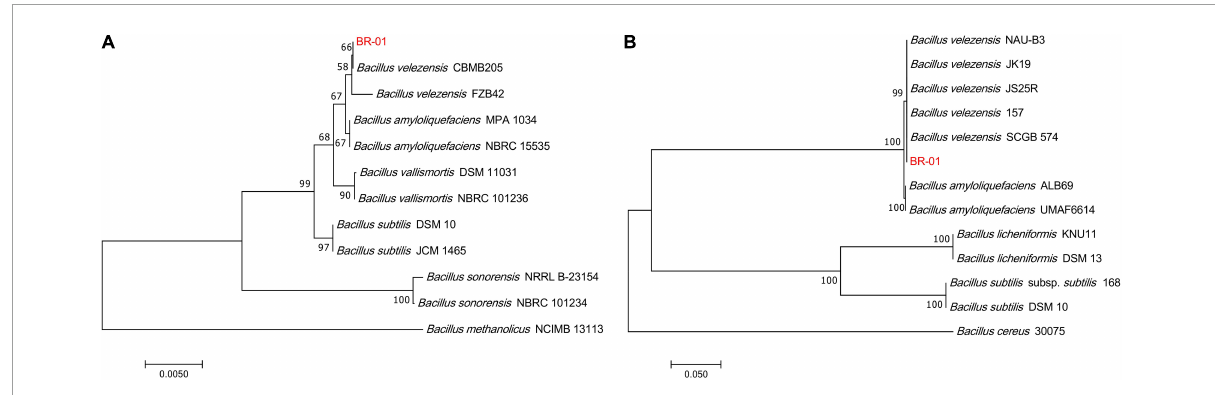
FIGURE4 Neighbor-joining phylogenetic tree of the antagonistic bacterium BR-01 were constructed by MEGA 11.0. (A) Based on 16S rDNA gene. (B) Based on gyrB gene. The numbers at the branches indicate the confidence level calculated by bootstrap analysis (1000). The scale bar shows the evolutionary distance between species.